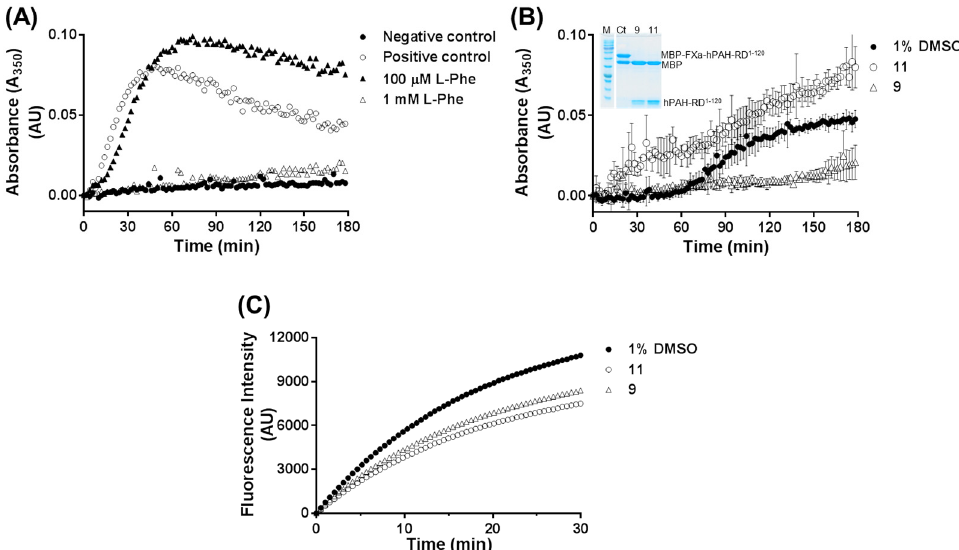
Figure 9. Self-association of dimeric hPAH-RD 1–120 following cleavage of the MBP fusion protein by Factor Xa (FXa) in the absence and presence of compounds 9 and 11 . ( A ) Time-course for the FXa cleavage reaction in the absence of compounds ( ; positive control) and in the presence of 100 μ M ( ) and 1 mM L-Phe ( ); ( ) dimeric MBP-FXa-hPAH-RD 1–120 fusion protein in the absence of FXa (negative control); errors bars were omitted for clarity. ( B ) Time-course for the reaction in the presence of 1% DMSO ( ) and 100 μ M of compounds 9 ( ) and 11 ( ); the inset panel represents the SDS-PAGE analysis of a control sample (Ct; consisting of MBP-FXa-hPAH-RD 1–120 ( ≈ 53 kDa) and MBP ( ≈ 40 kDa)) and cleaved hPAH-RD 1–120 ( ≈ 13 kDa) at time 180 min in the presence of compounds 9 and 11 . ( C ) Effect of selected 3HQ derivatives on FXa activity using Boc–Ile–Glu-Gly–Arg–AMC as the enzyme substrate; assays were performed in the presence of 1% DMSO ( ; control), and 100 μ M of compound 9 ( ) and 11 ( ) in 1% DMSO; data represent the mean of three independent experiments; FXa activity was calculated by determining the initial velocity of the reaction using the data points presented; FXa relative enzyme activity (considering 100% for the control) was 77% (compound 9; ) and 69% (compound 11; ).